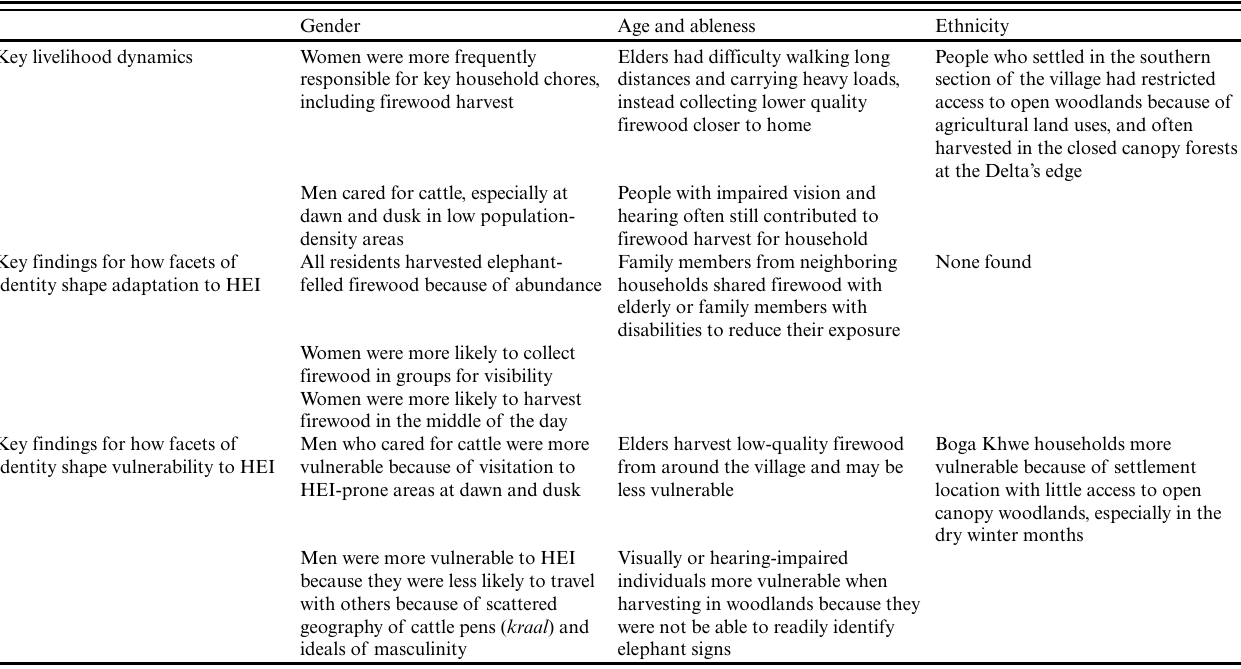
Table 4 . Summary findings showing how facets of identity played a role in livelihood dynamics, as well as how identities shaped vulnerability and adaptation to human-elephant interactions (HEI).